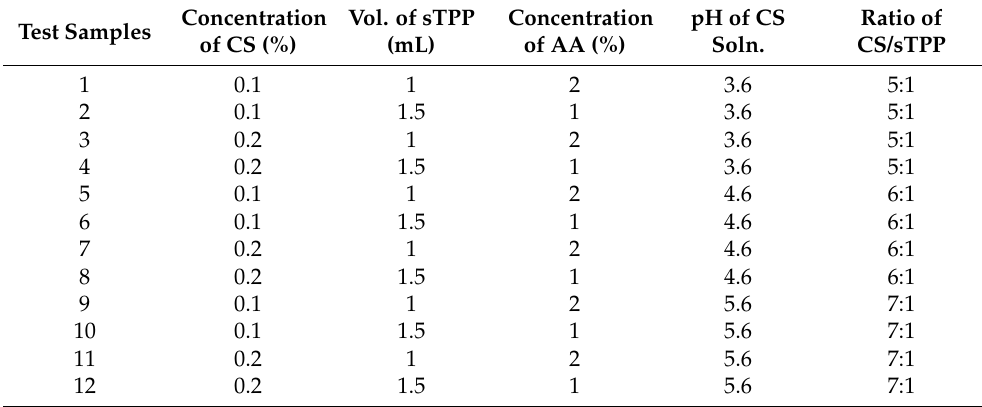
Table 1. Optimization of formulation based on changing different parameters.